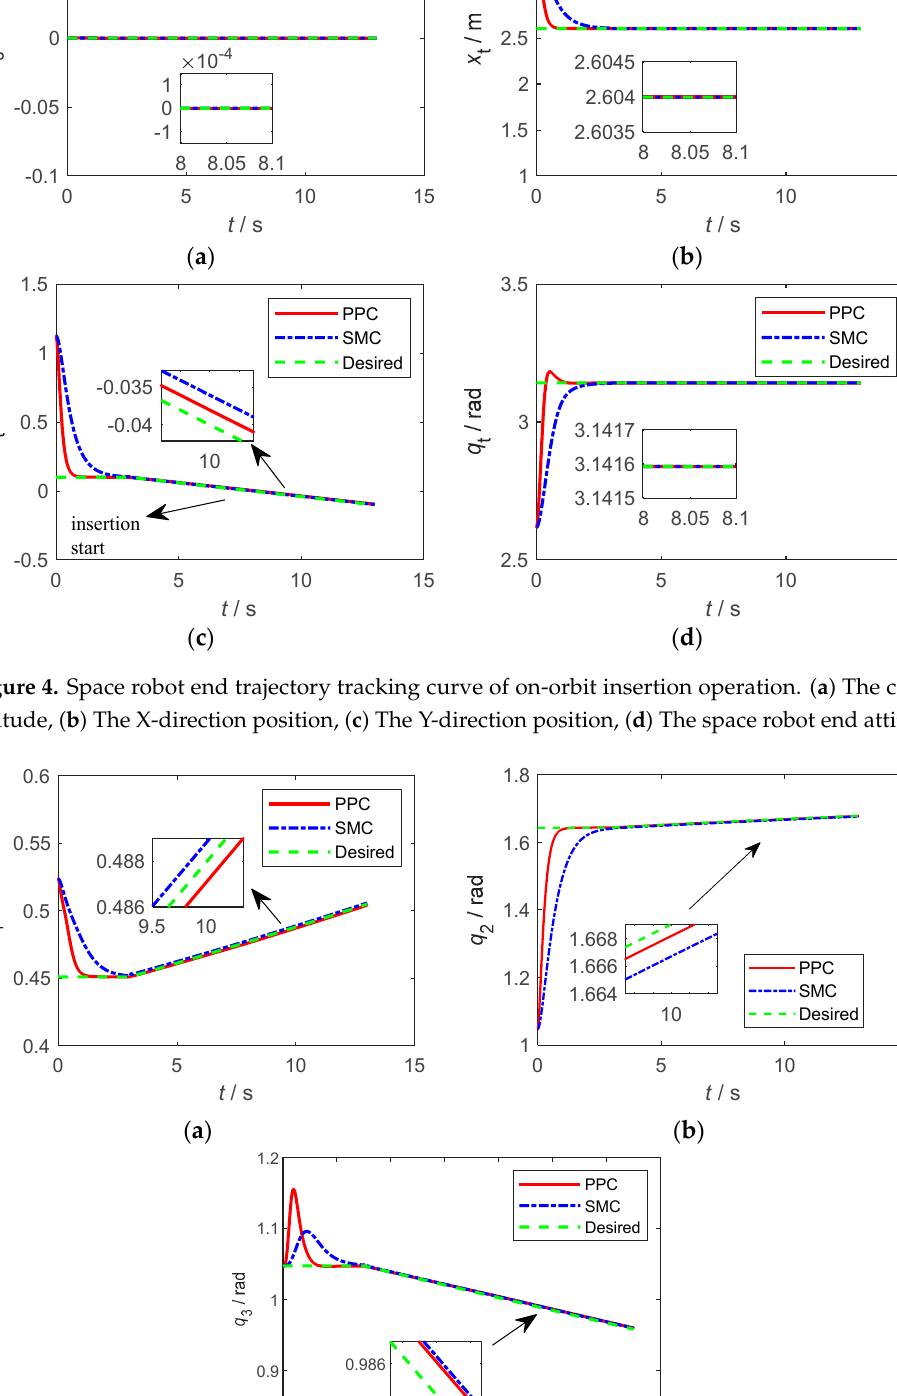
Figure 5. Joint trajectory tracking curve of on-orbit insertion operation. ( a ) The joint O 1 , ( b ) The joint O 2 , ( c ) The joint O 3 .